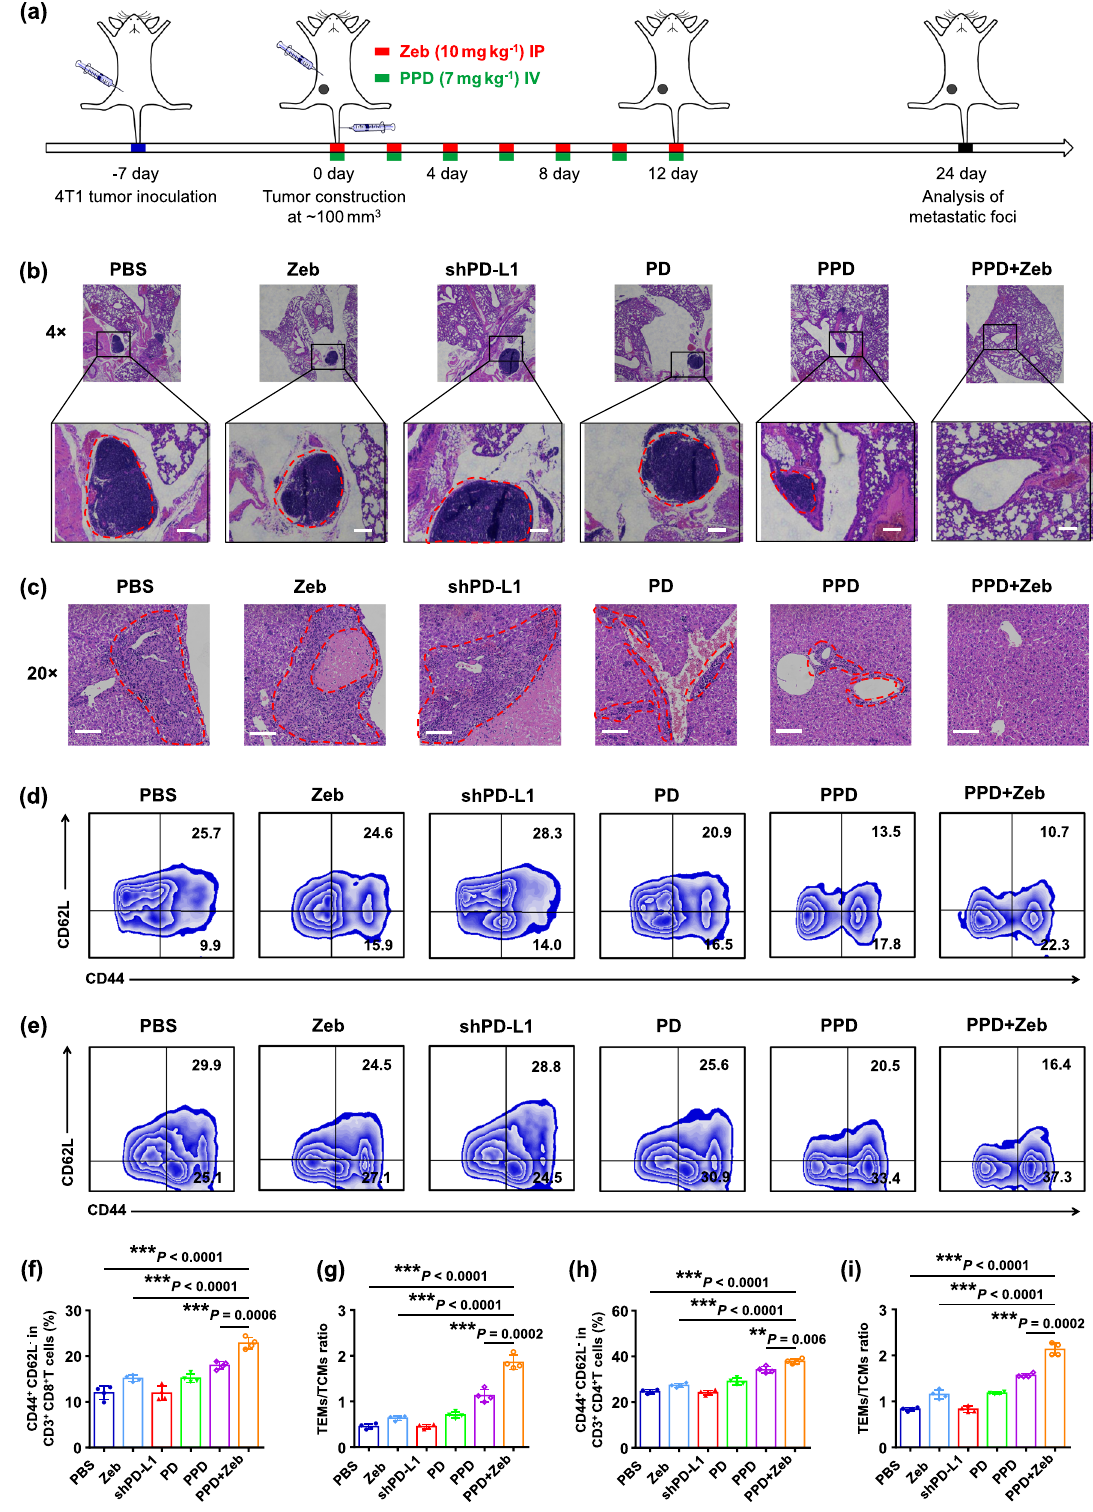
precipitated with cold anhydrous ether, fi ltered, and dried in vacuum, dialyzed (dialysis bag: cut-off 3500 Da), and lyophilized, and the white fl occulent solid